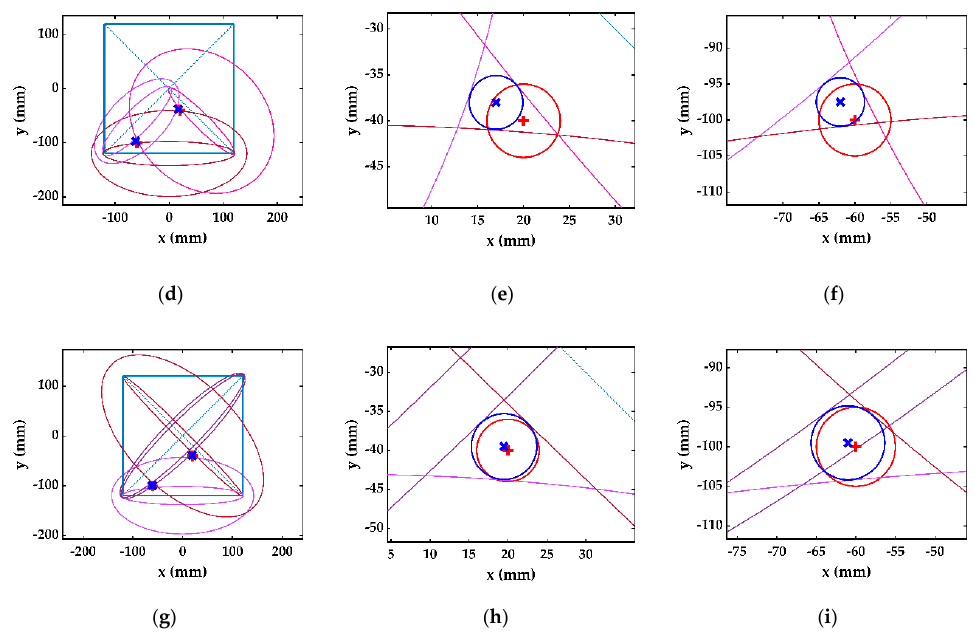
Figure 16. Multiple damage detection, estimated (blue) and actual (red): ( a ) single-stage detection; ( b ) D 1 at first stage; ( c ) D 2 at first stage; ( d ) two-stage detection; ( e ) D 1 at second stage; ( f ) D 2 at second stage; ( g ) three-stage detection; ( h ) D 1 at third stage; ( i ) D 2 at third stage.